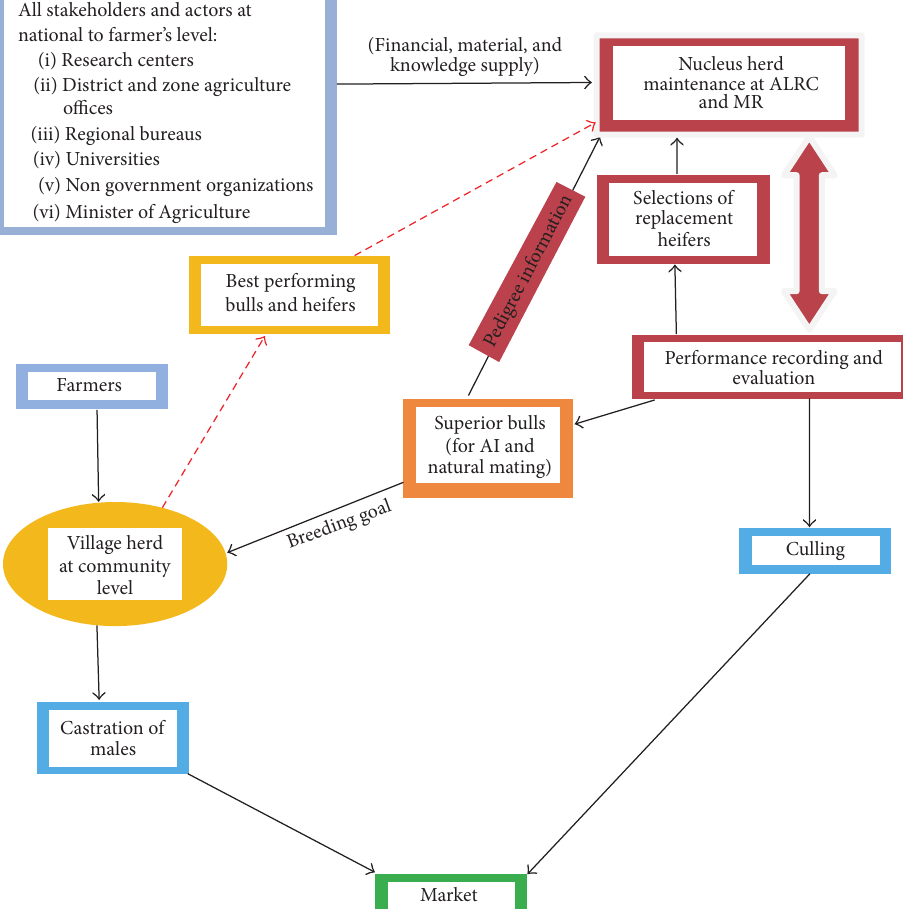
Figure 5: Closed breeding scheme for conservation and sustainable use of Fogera cattle